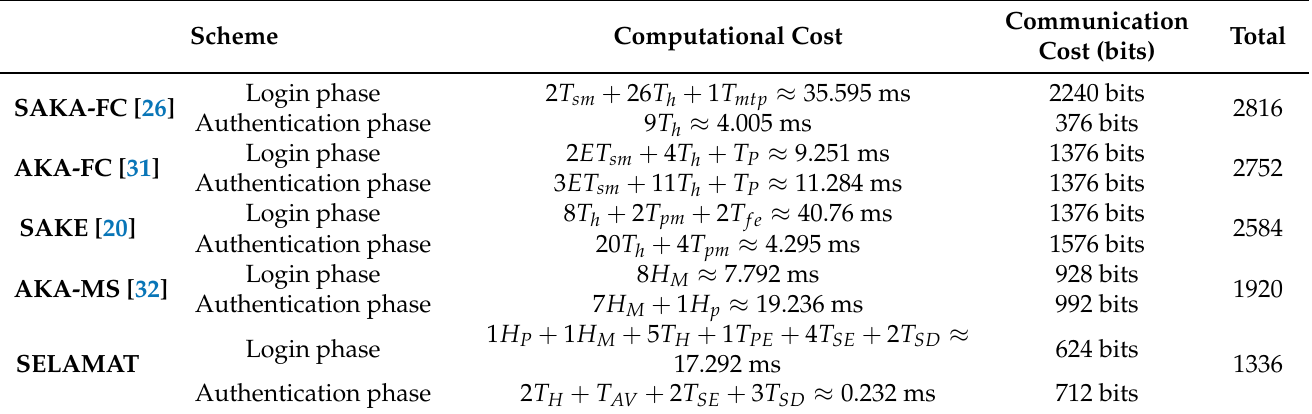
Table 5. Performance comparisons.